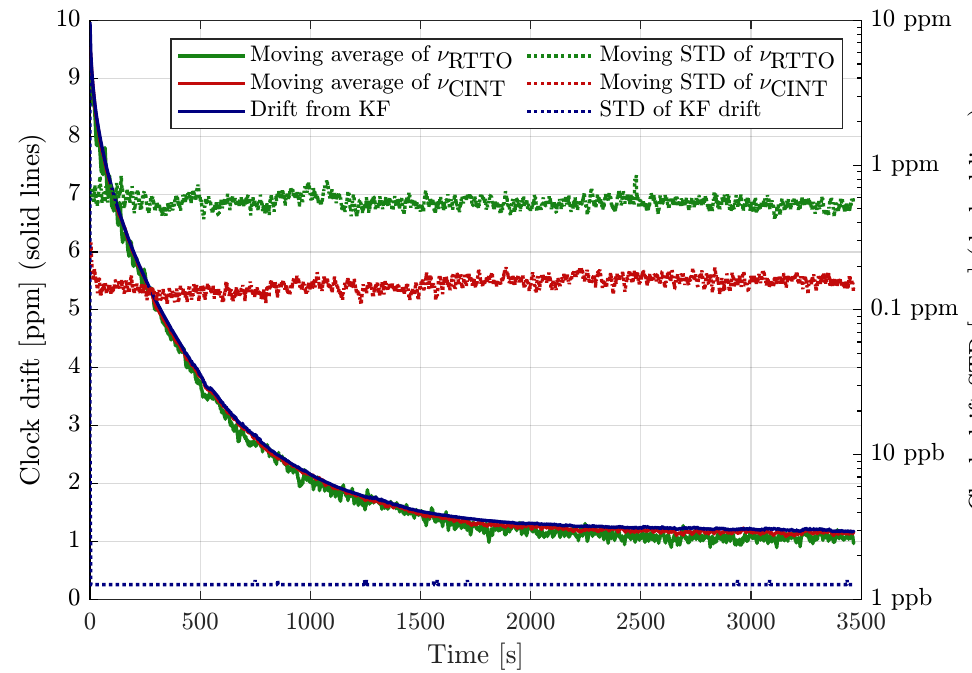
Figure 2. Moving average (solid lines, left axis) and moving STD (dashed lines, right axis) of relative CFO based on RTTO and C int , drift estimated by Kalman filter and its variance included for